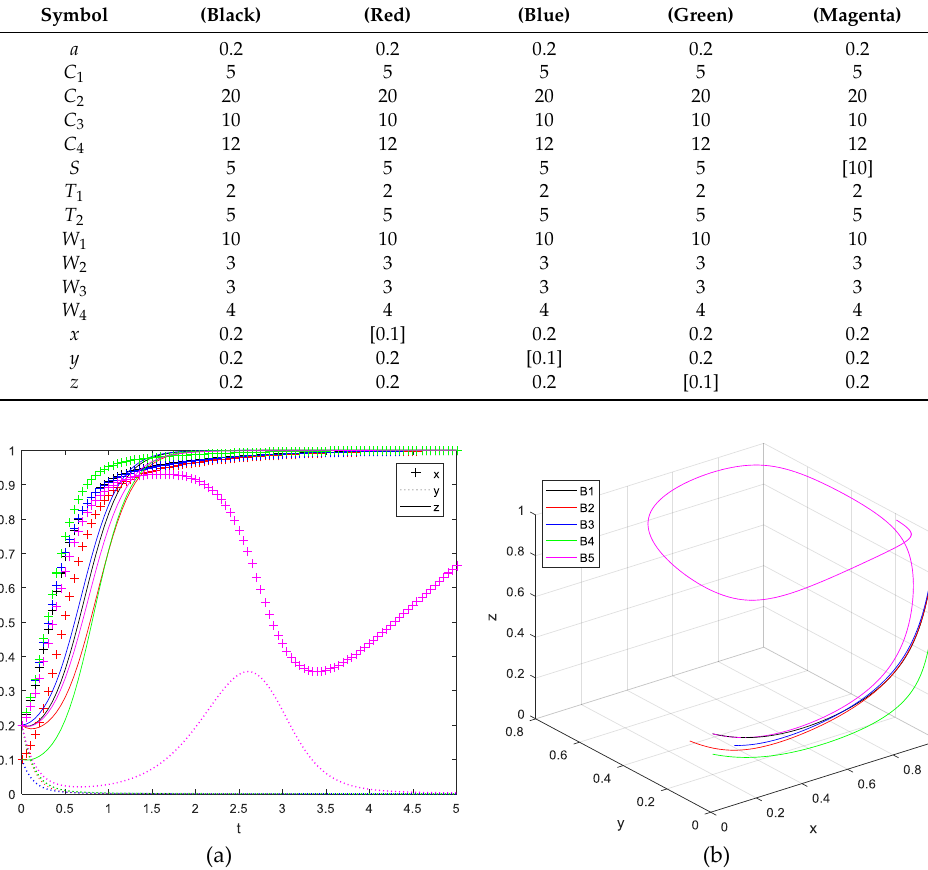
Figure 5. Evolution trend chart of oversupply scenario. ( a ) Two-dimensional evolution diagram, ( b ) Three-dimensional evolution diagram.